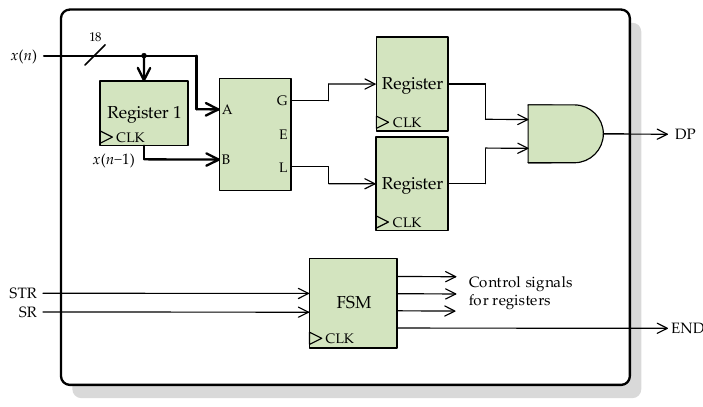
Figure 11. Architecture of the peak detector. Table 1. Usage of FPGA resources.